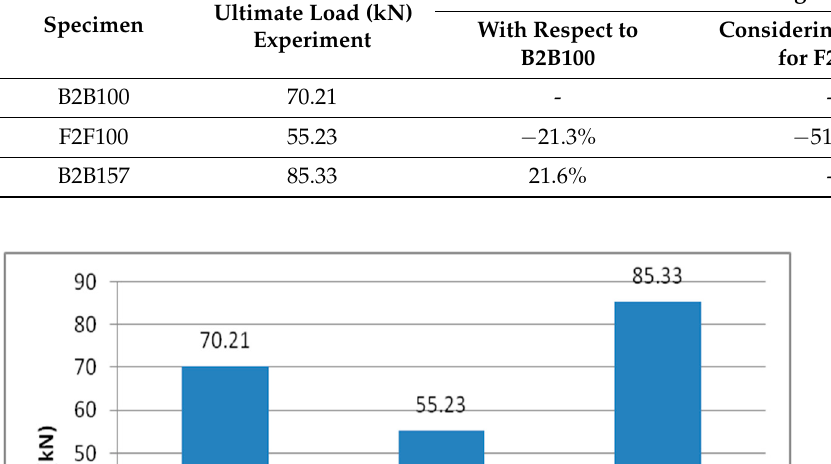
Table 2. The ultimate load of the built-up sections.